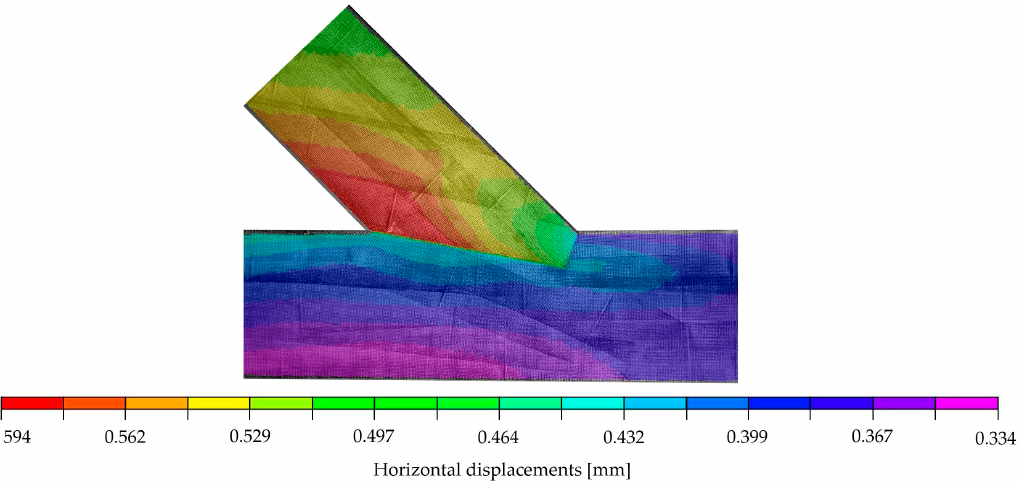
Figure 5. DIC-vertical displacements on the surface of specimen A_5 at 70.1 kN. 3. Mathematical Model of Timber with the Finite Element Implementation Various experimental tests of timber joints show a strong dependence of the results on the inhomogeneous material properties of the sample, in particular the arrangement and twist of the fibres, as well as the presence of knots [9,10]. Furthermore, the results are dependent on the chosen geometry of the joint and the accuracy of craftsmanship in re- gard to the execution [7]. A precise prediction of the load-bearing behaviour considering the inhomogeneity of the material, as well as the damage and the accompanying redistri- bution of forces in certain areas, requires a detailed analysis of the properties of each sam- ple. A very detailed modelling and subsequent numerical analysis in terms of non-linear- elastic, elastic-plastic, visco-plastic or fracture mechanics are, therefore, necessary to iden- tify the propagation of the failure. Another approach is to use novel hysteretic models, which are capable of simulating the complex, non-linear behaviour of materials [11–13]. In order to obtain a first assessment of a joint without complicated calculations, the